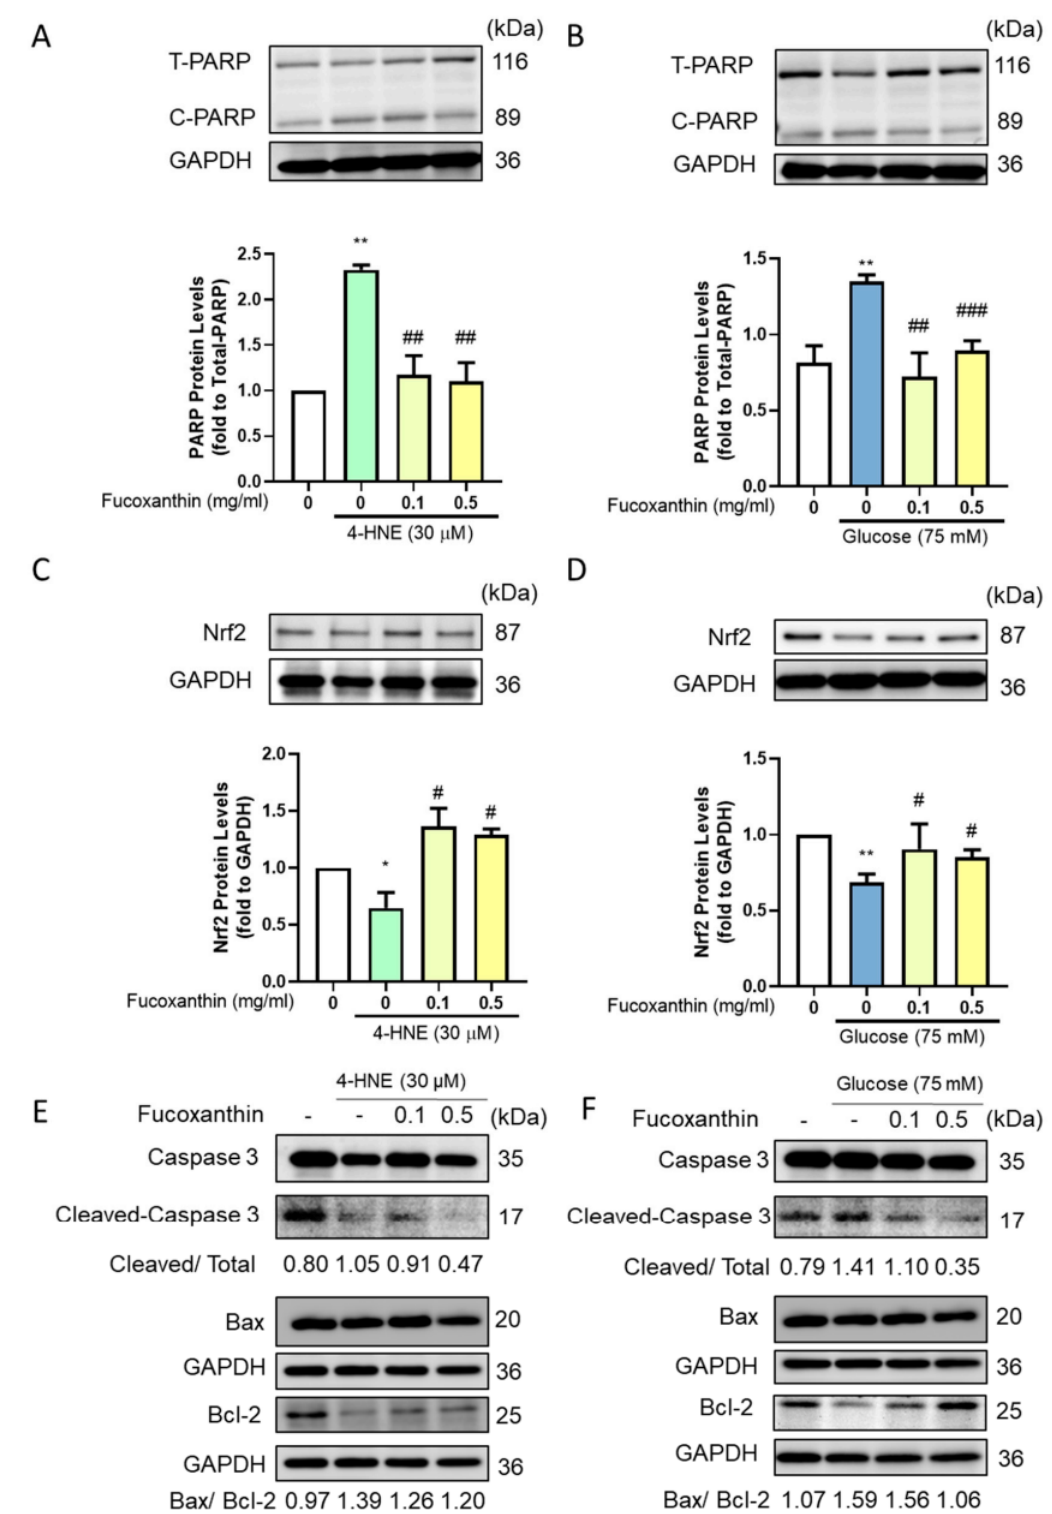
Figure 3. E ff ects of fucoxanthin on 4-HNE- and high glucose-induced ARPE19 apoptosis-related protein expression. We used Western blotting to analyze the ( A , B ) PARP; ( C , D ) Nrf2 protein; and ( E , F ) apoptosis- related protein expression ( n = 4). *, p < 0.05; and **, p < 0.01 compared with the non-treated group. #, p < 0.05; ##, p < 0.01; and ###, p < 0.001 compared with the induced group (glucose 75 mM / 4-HNE 30 µ M). T-PARP, total PARP; C-PARP, cleaved